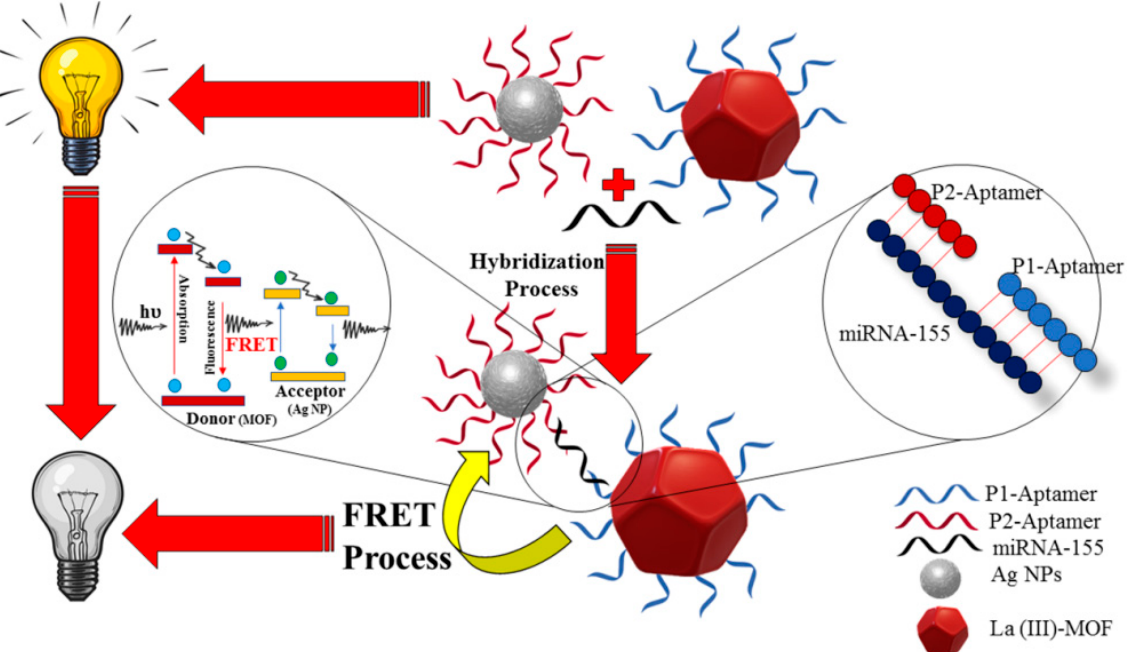
Figure 12. Schematic diagram of a biosensor based on detection of miRNA-155 [75]. Zhang et al. [76] confirmed through experiments and verified by theory that, in this sandwich structure, the coupling between the donor and plasmon is dominant, which is demonstrated in Figure 13a. Tuncay et al. [77] placed the donor and acceptor layers on the same side of the metal nanoparticles so that coupling and energy transfer between NMNPs and quantum dots could achieve selective control. Furthermore, they also found that the non-radiative energy transfer enhanced by plasmon coupling was closely related to the location of coupled donor–acceptor pairs, as shown in Figure